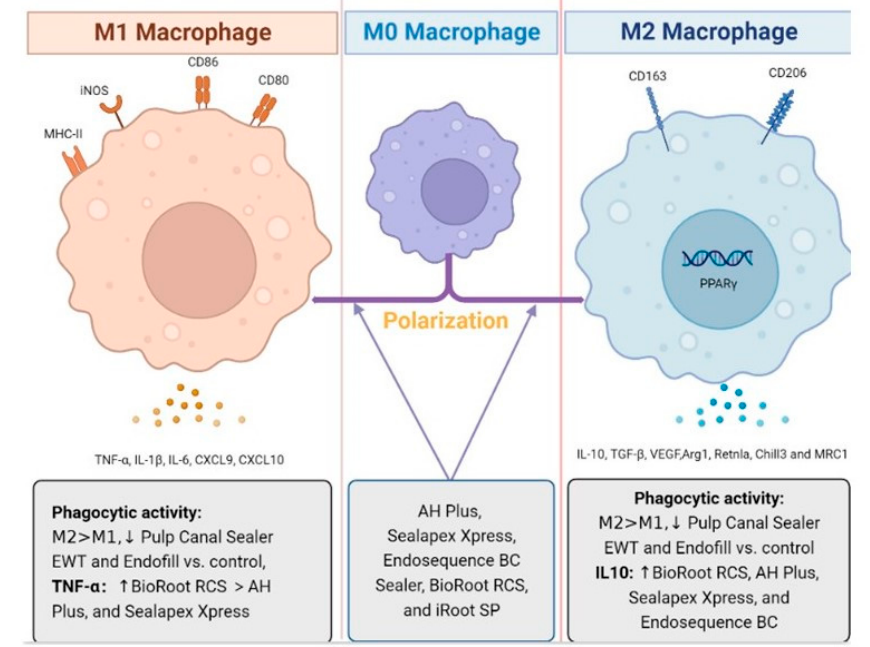
Figure 4. Modulatory effects of endodontic sealers on macrophage polarization, cytokine production, and phagocytic activity. AH Plus, Sealapex Xpress, Endosequence BC Sealer, BioRoot RCS, and polarization. Pulp Canal Sealer EWT and Endofill decreased the phagocytic activity of both